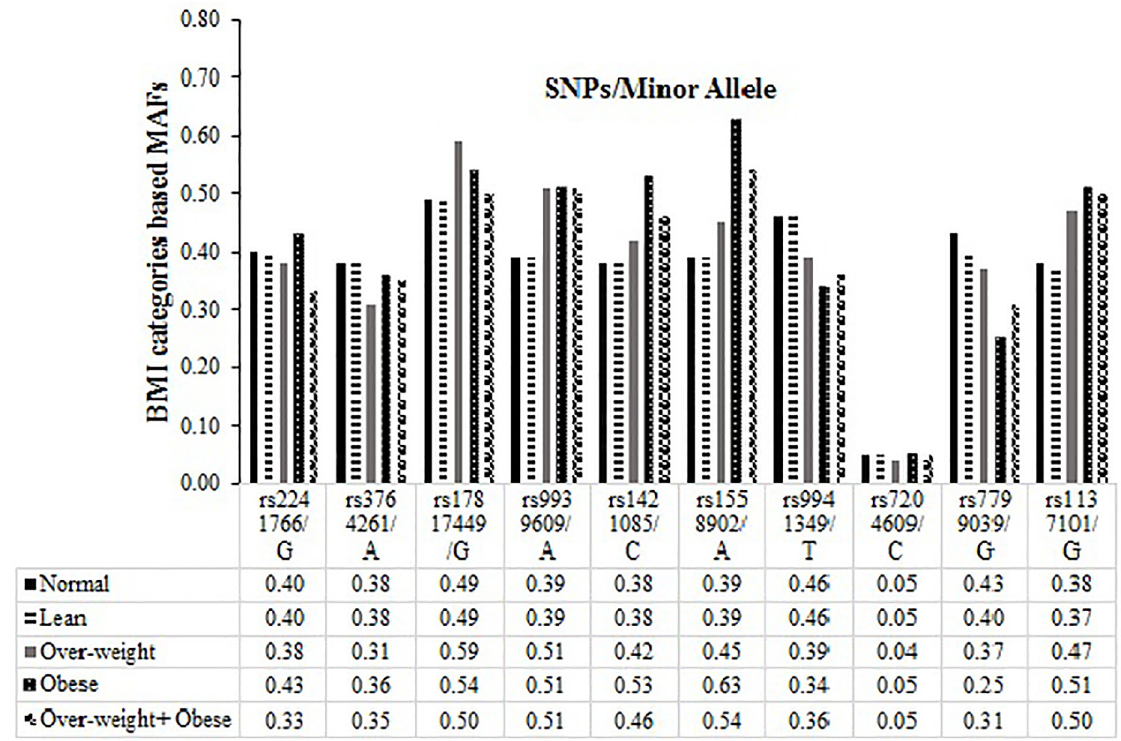
Fig 1. Comparison of minor allele frequencies (MAFs) based on BMI categories. The BMI categories-based distribution of the MAFs of all genetic variants is presented as bar graph. The y-axis represents frequencies of the minor alleles per BMI categories (Normal, Lean, Over- weight, Obese, and Over-weight + Obese) while genetic variants with corresponding minor alleles are shown in the x-axis. MAFs were calculated using online software SNPStats.